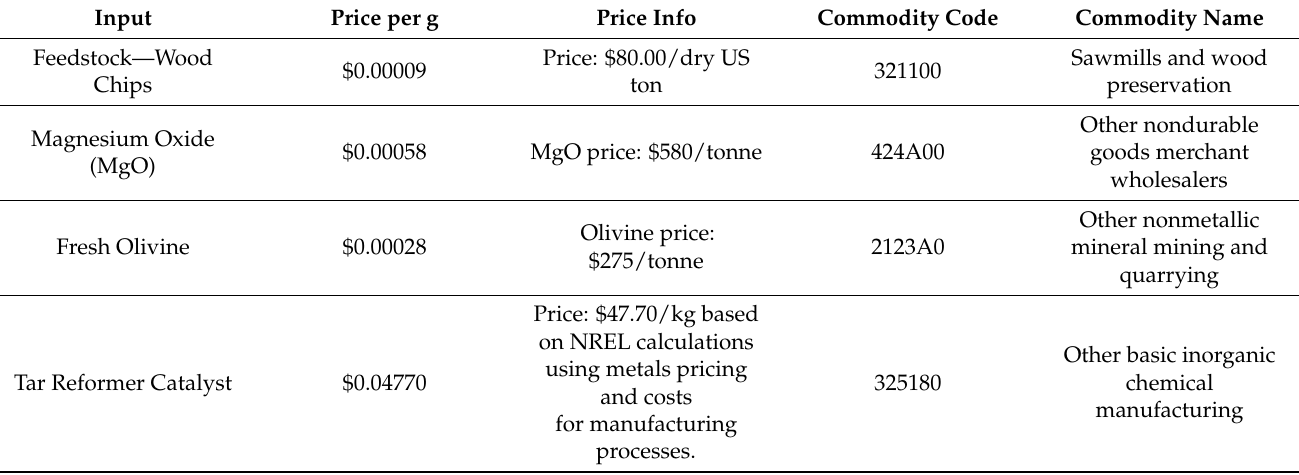
Table A1. Crosswalk between inputs and BEA industries and prices used to transform from quantities to monetary